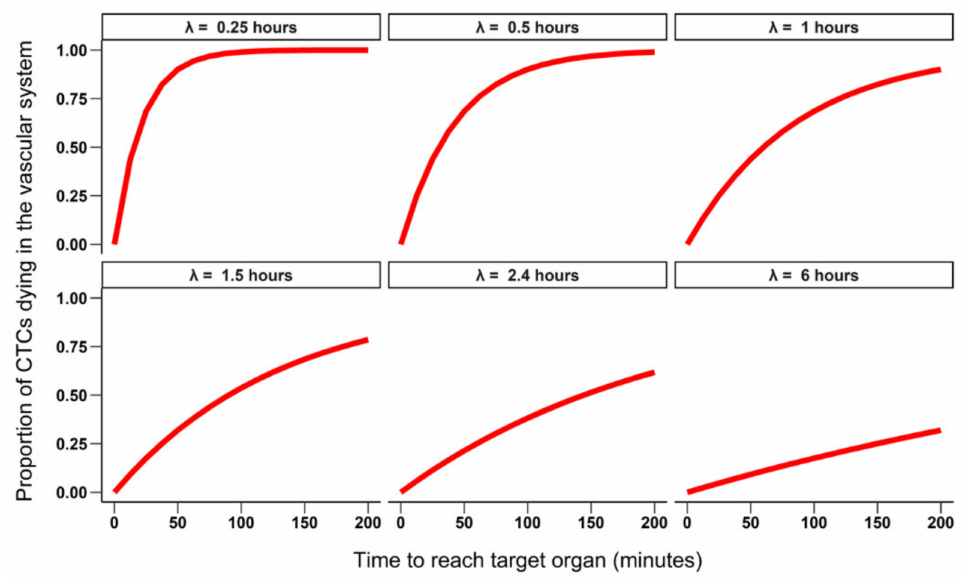
Figure 3. Proportion of CTCs dying in the vascular system as a function of their half-life (ranging from λ = 0.25 to 6 h) and the time required to reach the target organ (0 to 200 min). The values for M, Pe and the number of shed cells are the same as in Figure 2.